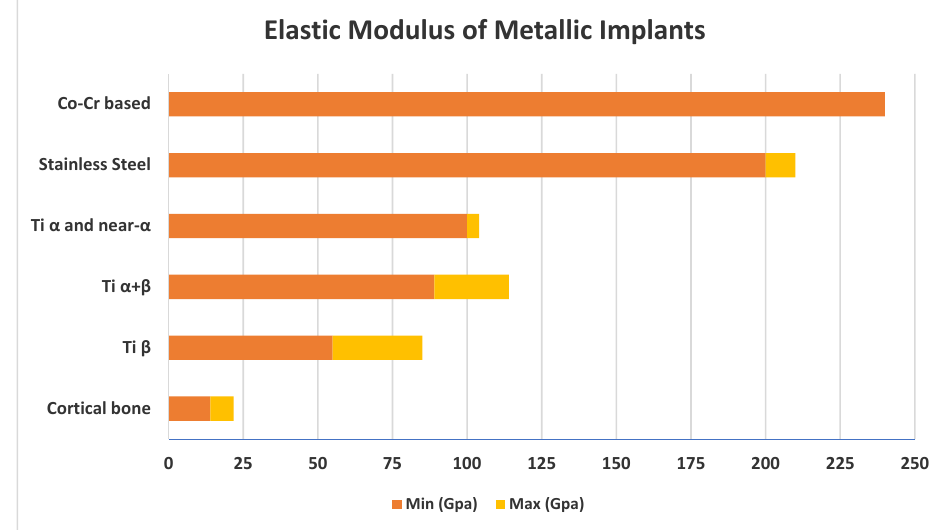
Figure 5. Range of elastic modulus of metallic material groups [61] . Table 2 summarizes the advantages and disadvantages of metal implant materials. Table 2. Advantages and disadvantages of metal implant materials.